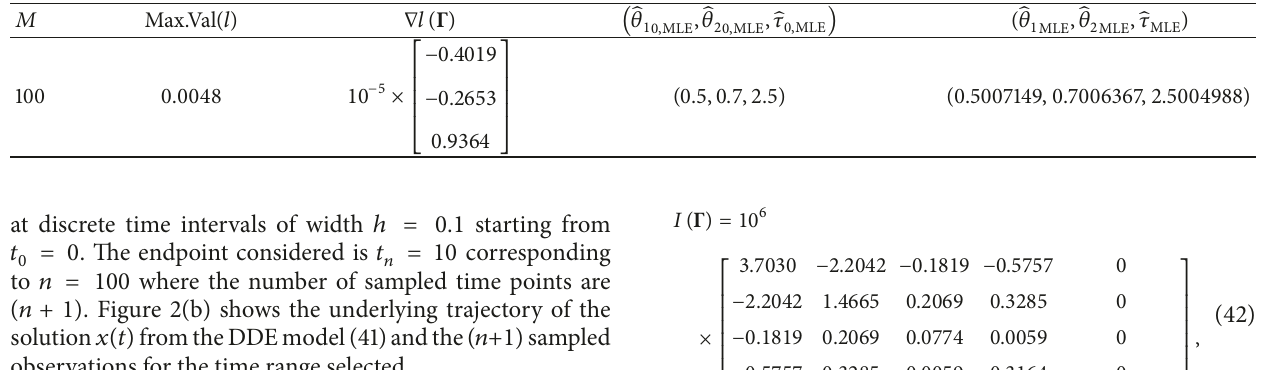
(̂𝜃 , ̂𝜏 ) for the DLDEM with single delay with ℎ = 0.1 MLE MLE